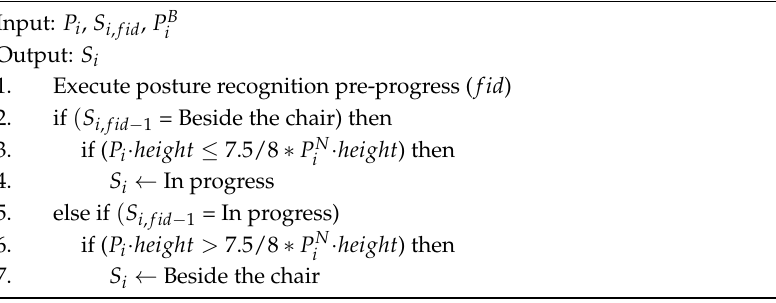
Algorithm 5 Posture recognition (between in progress and beside the chair)